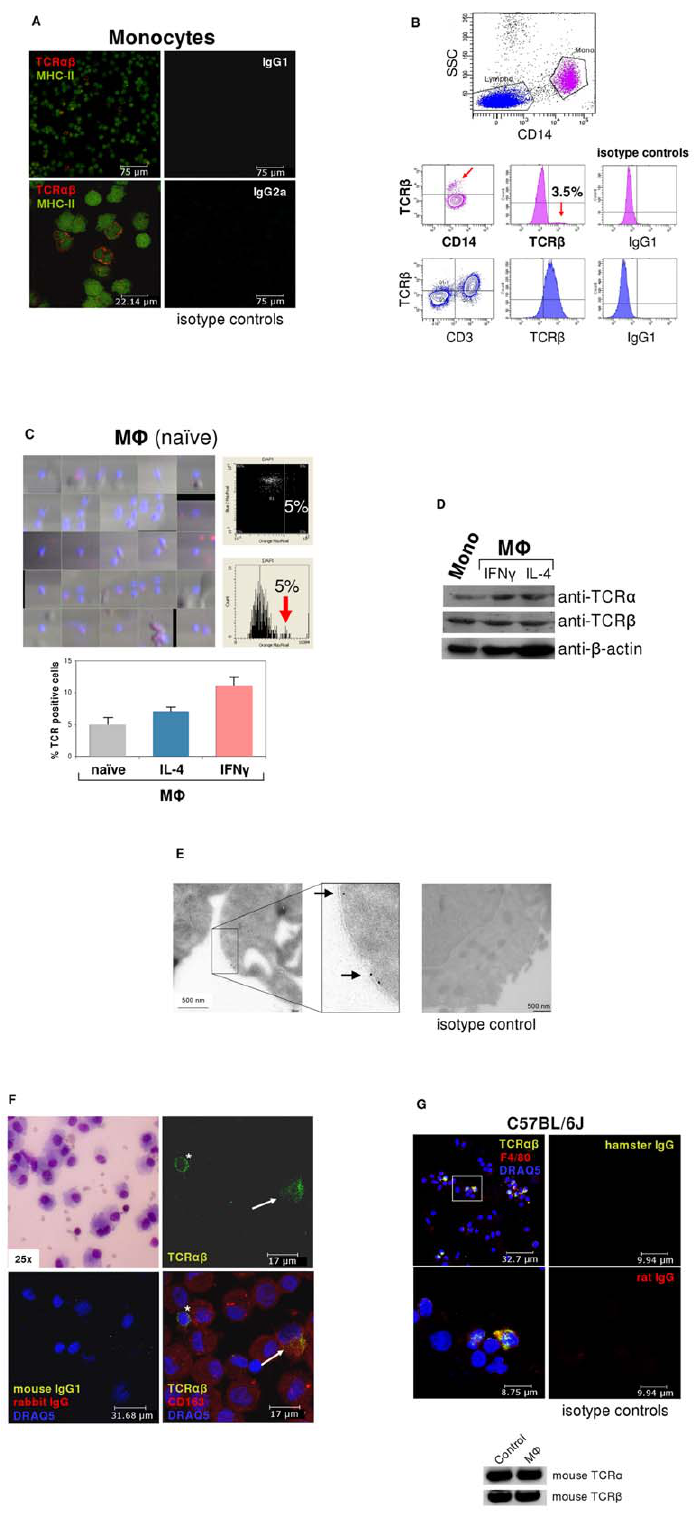
Figure 1. T CR ab expression by subpopulations of human and murine monocytes/macrophages. ( A ) Fluorescence immunocytochemistry demonstrating that a , 5% subpopulation of human peripheral blood CD14 + /MHC-II + monocytes expresses the T CR ab . CD14-MACS purified peripheral blood monocytes were isolated from a healthy donor and double-immunostained with Abs against the T CR ab (red) and MHC-II (green). Isotype controls for the anti- T CR ab and anti-MHC-II antibodies are shown (right). Scale bars are indicated. Data shown are representative of n=12 donors. ( B ) Flow cytometry of peripheral blood mononuclear cells from a healthy individual demonstrates the presence of the TCR b on the surface of a CD14 + monocyte subpopulation (3.5%, red arrows). Staining for TCR b and lineage surface markers are shown. CD14 + monocytes are in pink color,